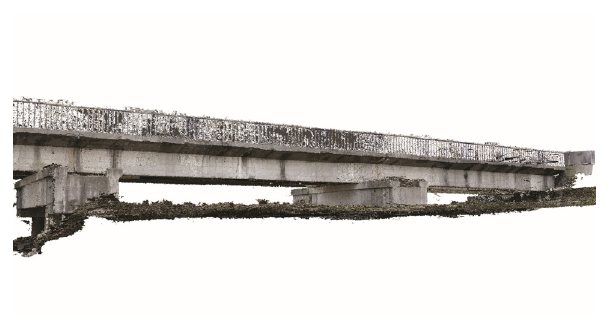
Figure 4. Current state of the bridge